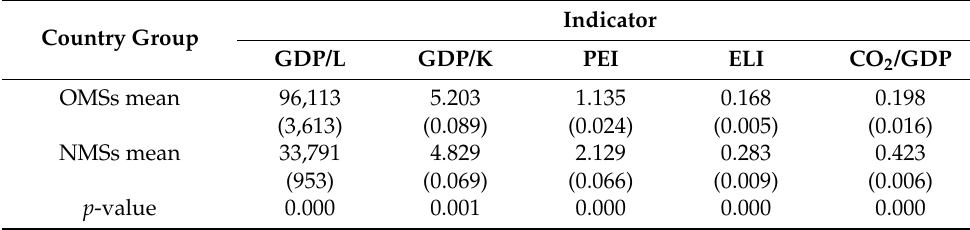
Table A6. Results from the two-group mean comparison test. Country Group